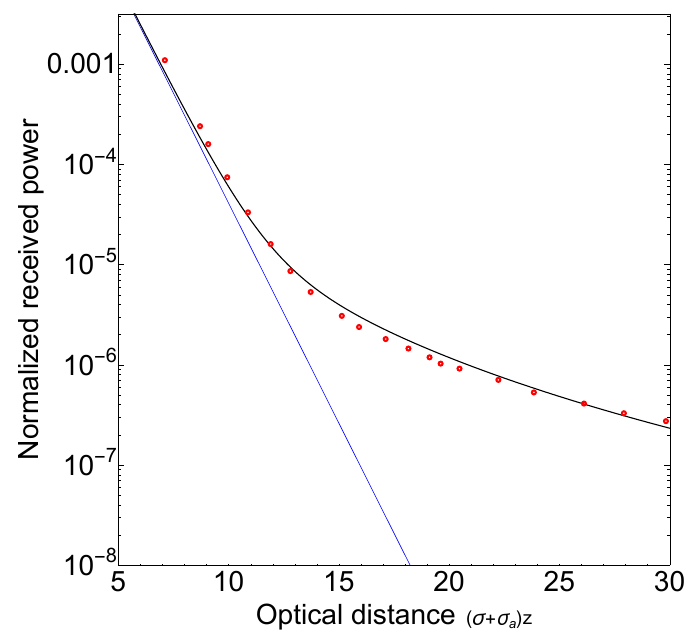
Figure 9. Normalized received power versus optical source-receiver distance (symbols [7]). The results of calculations within the small-angle approximation for the Henyey-Greenstein phase function ( γ 0 = 1 − g = 0.07) are shown by solid curve. The attenuation of non-scattered radiation, Beer’s law, is displayed by straight